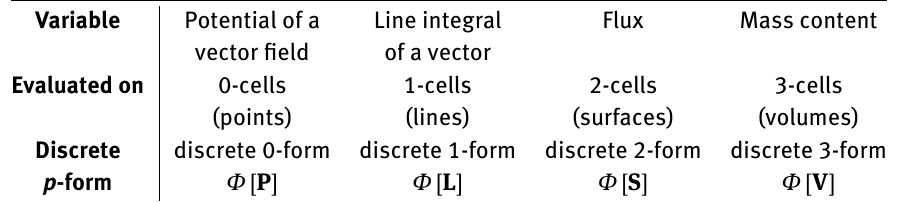
Table 2: Examples of discrete p -forms